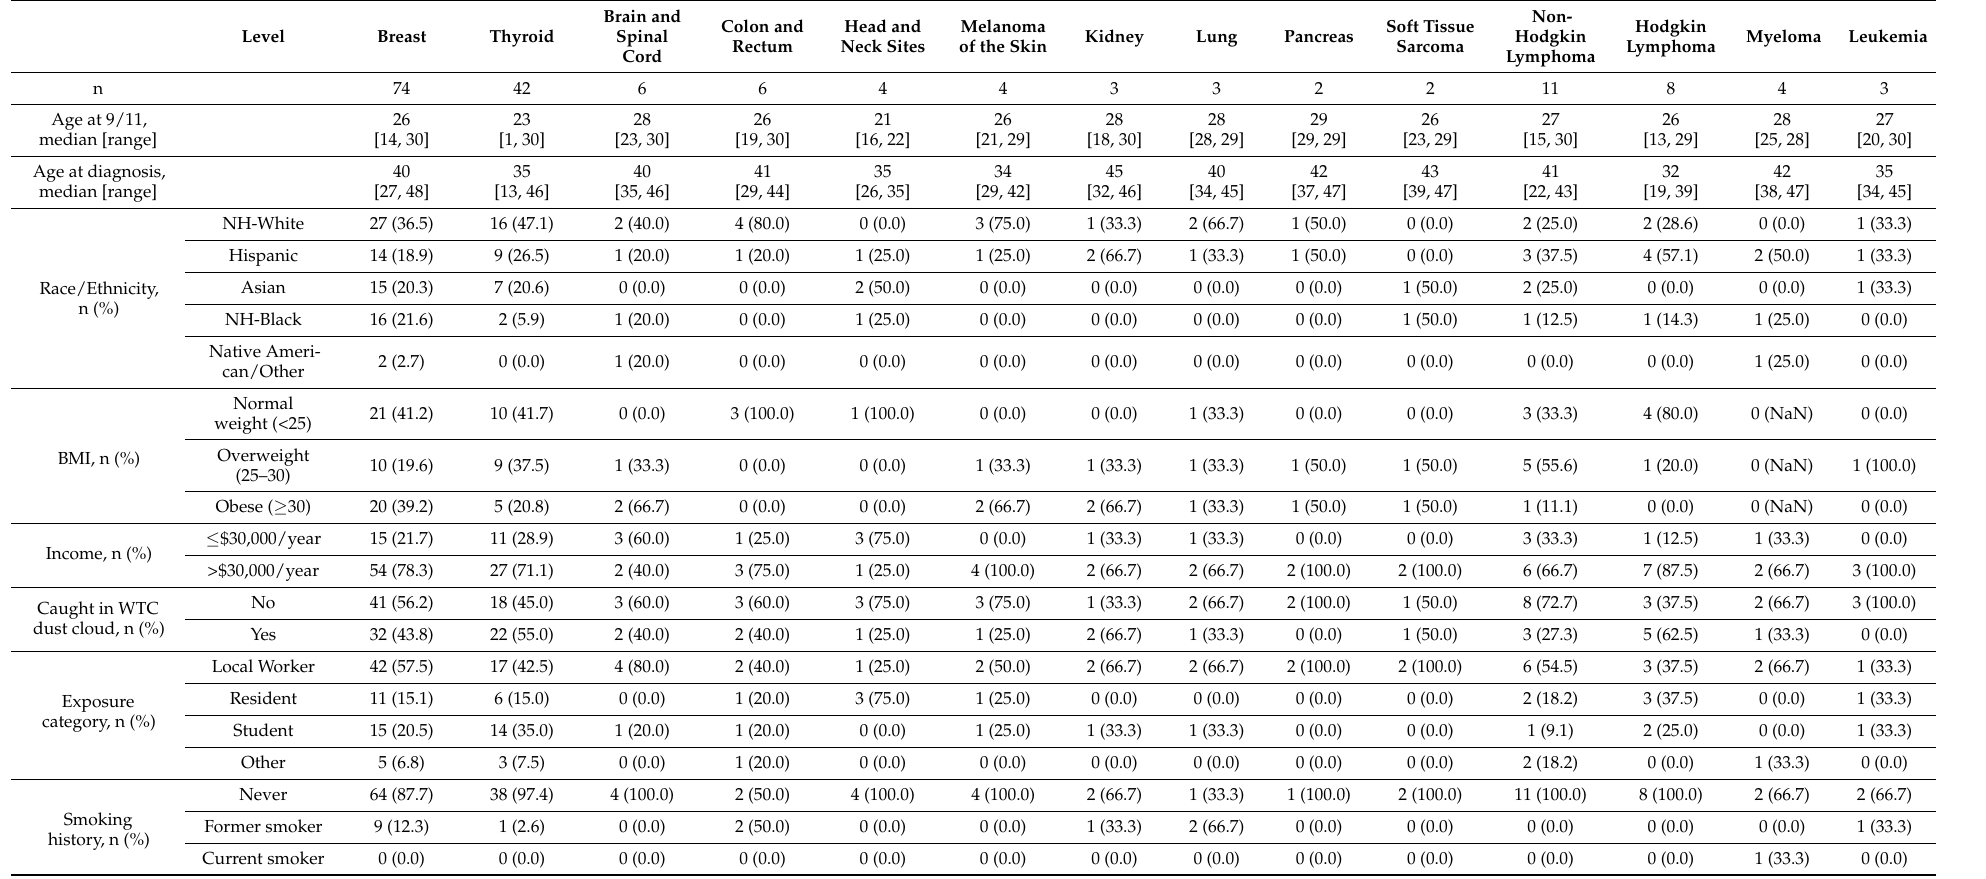
Table A1. Characteristics of female EYA diagnosed with the most common cancers included in the WTC EHC cancer analysis (as of 31 July